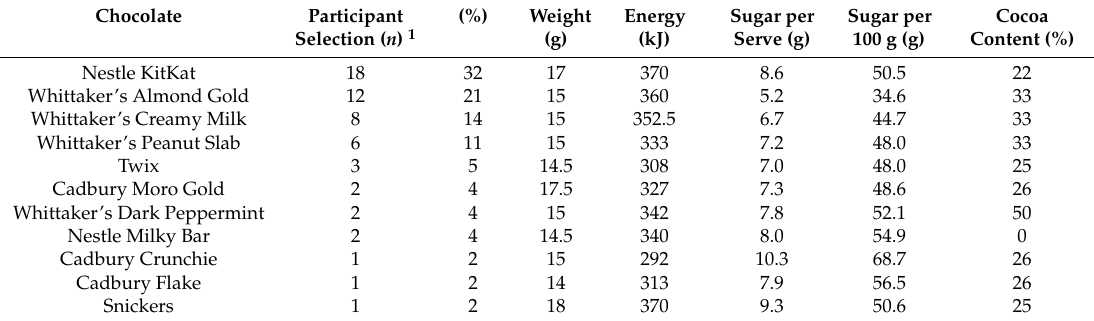
Table 2. Participant chocolate selection and nutrition